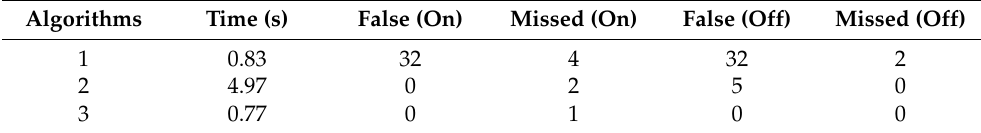
Table 4. Event detection results of three algorithms.